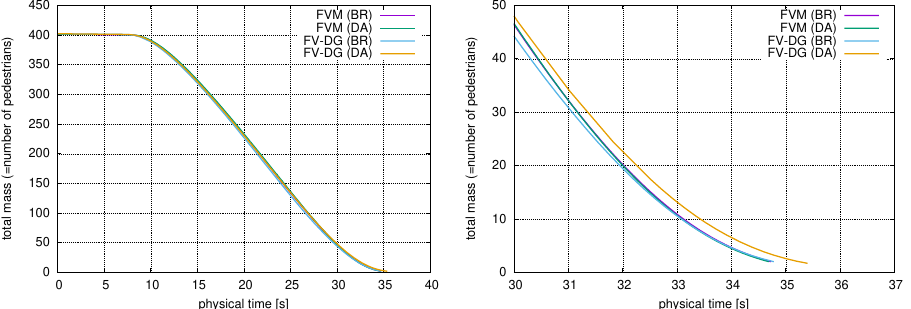
Figure 3. Domain with one circular obstacle, the time evolution of the total number of pedestrians M ( t m ) for the finest grid # T h = 9056 (FVM) and # T h = 9082 (FV-DG), total view ( left ) and the detailed view close to the end of the evacuation ( right